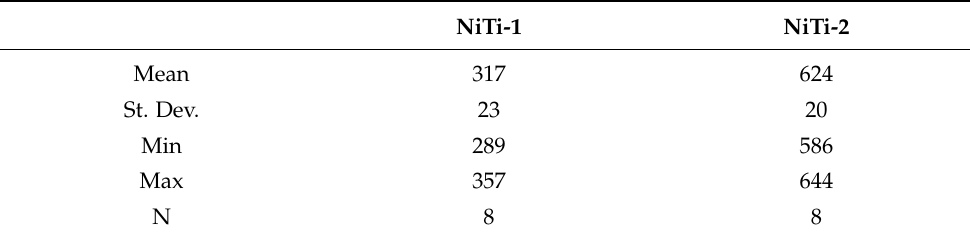
Table 3. Descriptive statistics for hardness measurements for the NiTi-1 and NiTi-2 samples.